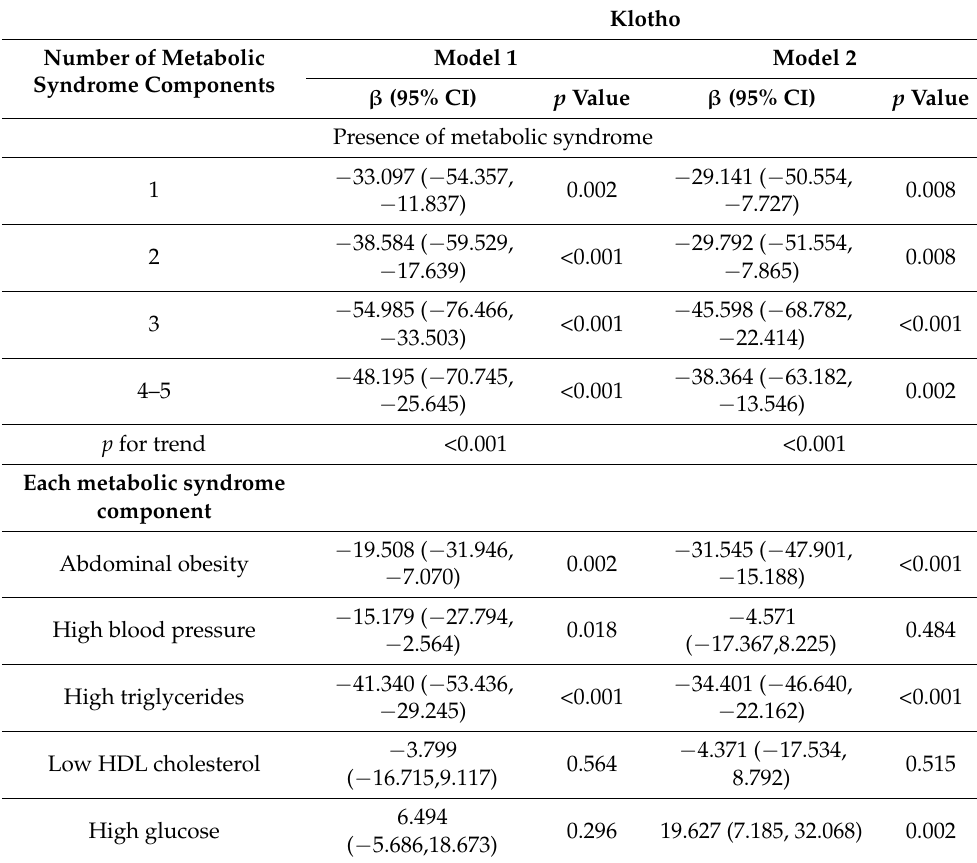
Table 3. Regression coefficients of the presence and number of metabolic syndrome components with